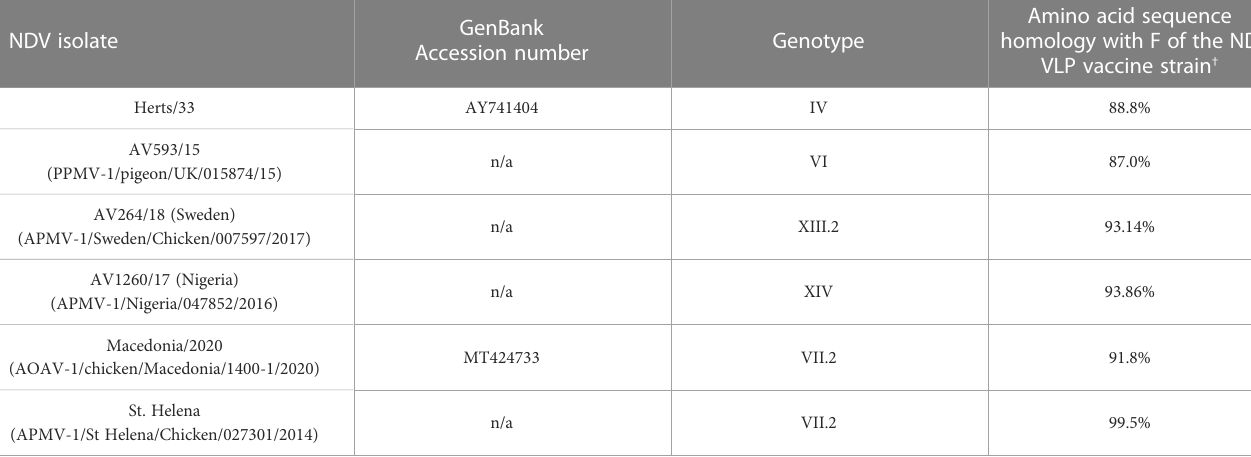
TABLE 2 Newcastle disease virus isolates selected for hemagglutination inhibition and virus neutralization testing.